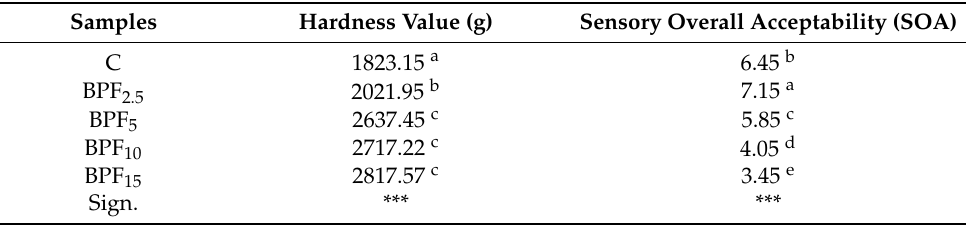
Table 5. Physical properties and sensory overall acceptability of biscuit